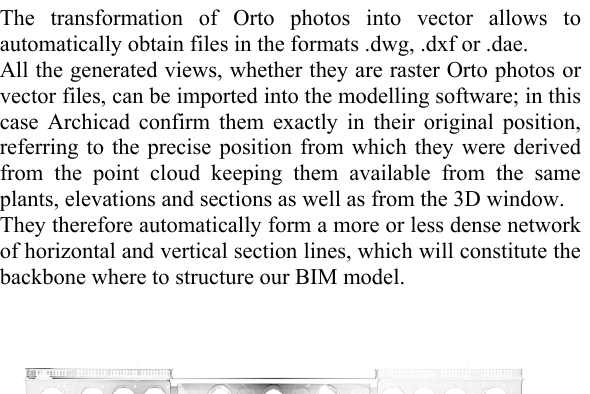
Figure 6: the lunette-like with double-curved nails The barrel vault has been placed in Archicad taking as reference vector section by Point-Cab extruded along its length on the plant generated by Point-Cab. Bases of lateral lunettes correspond to the arched openings in the walls Grasshopper acquires the entities of Archicad and breaks them down into its constituent elements: the extrusion of the generating vault and the arches of the lunettes. After that the various geometrical operations are elaborated in terms of projection of the base lines on the topological plan of the barrel vault.